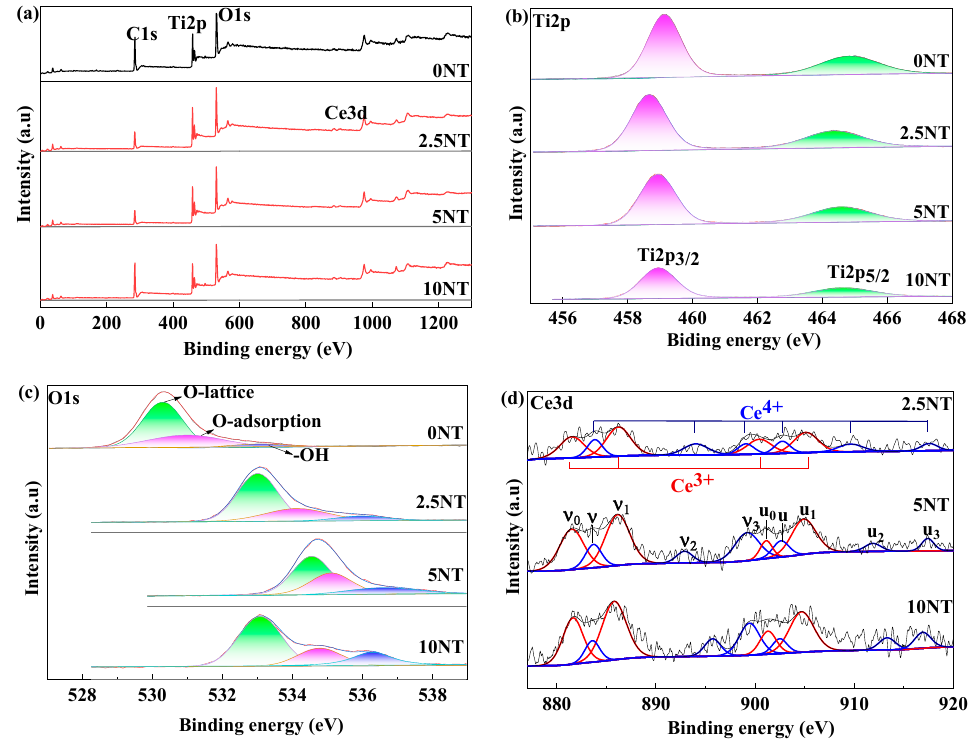
Figure 6. XPS spectrum curves of the TNTs. ( a ) Full spectrum; ( b ) Ti; ( c ) O; ( d ) Ce.